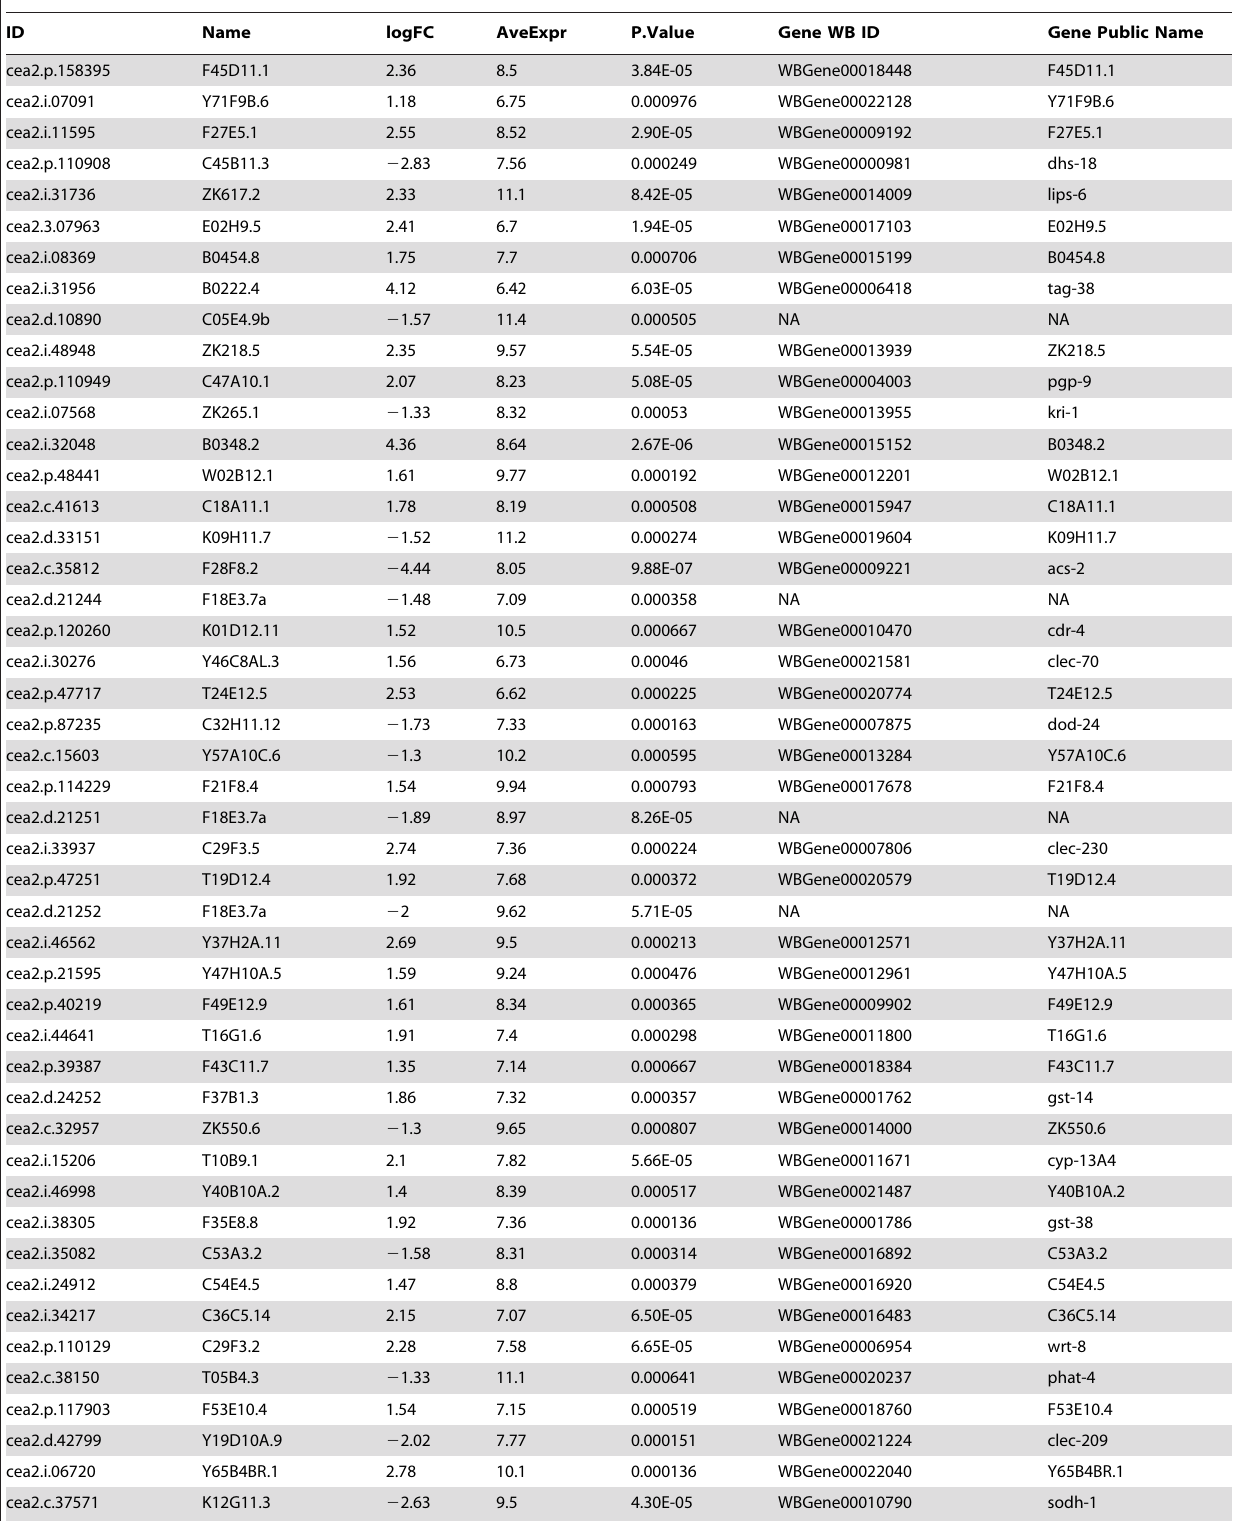
Table 1. List of differentially regulated genes in nhr-49 compared to wild-type animals.